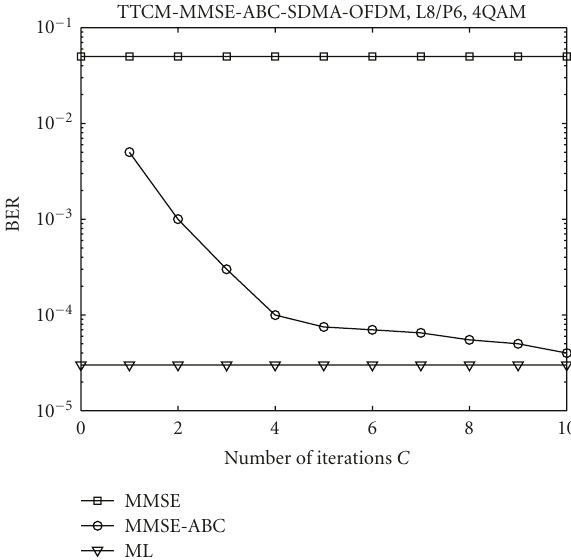
Figure 7: BER versus population size ( X ) performance with the number of iterations fixed at C = 5 for 8 × 6 system.